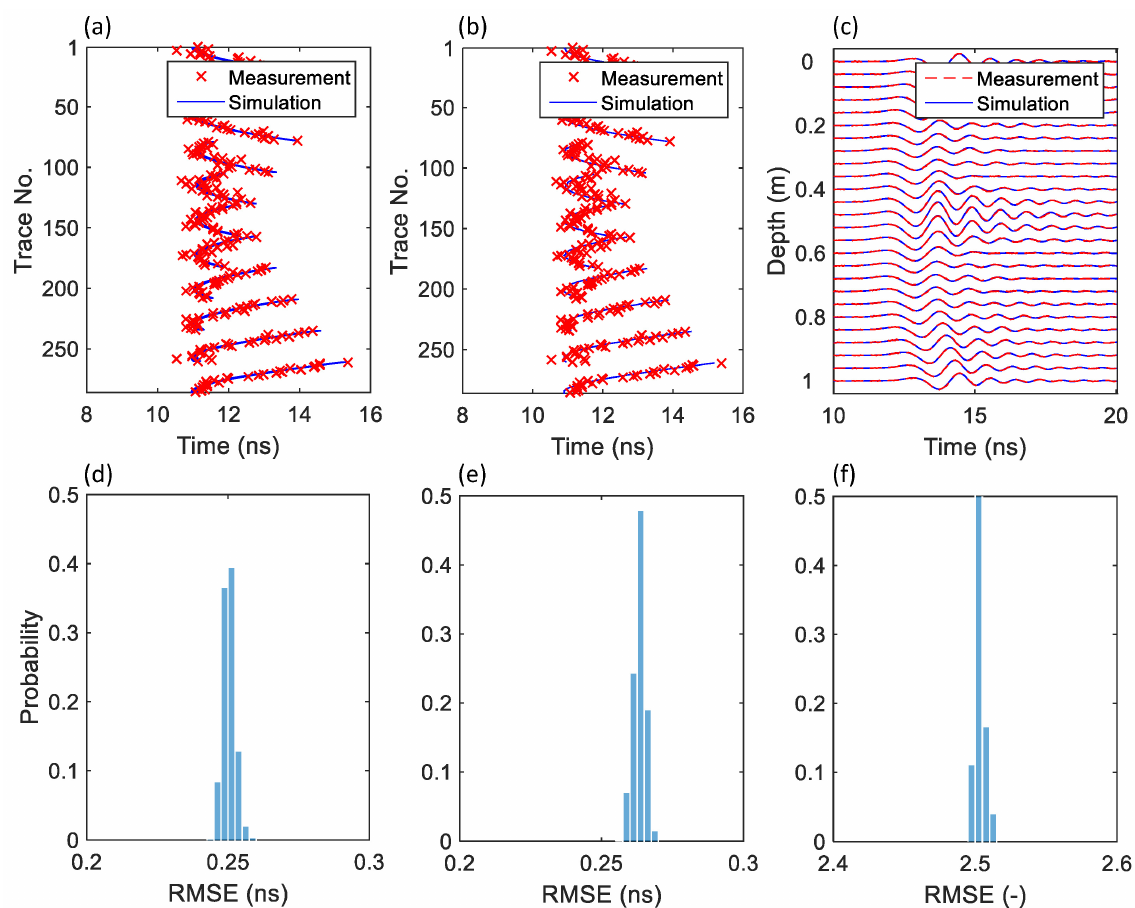
Figure 13. Fitting of the measurement data by the posterior models derived from Bayesian inversion with smooth model constraint using ( a ) the straight-ray model with first-arrival traveltime data, ( b ) FDTD model with first-arrival traveltime data, and ( c ) FDTD model with waveform data, respectively. ( d – f ) Histograms of the RMSE values of the posterior solutions in correspondence with the three